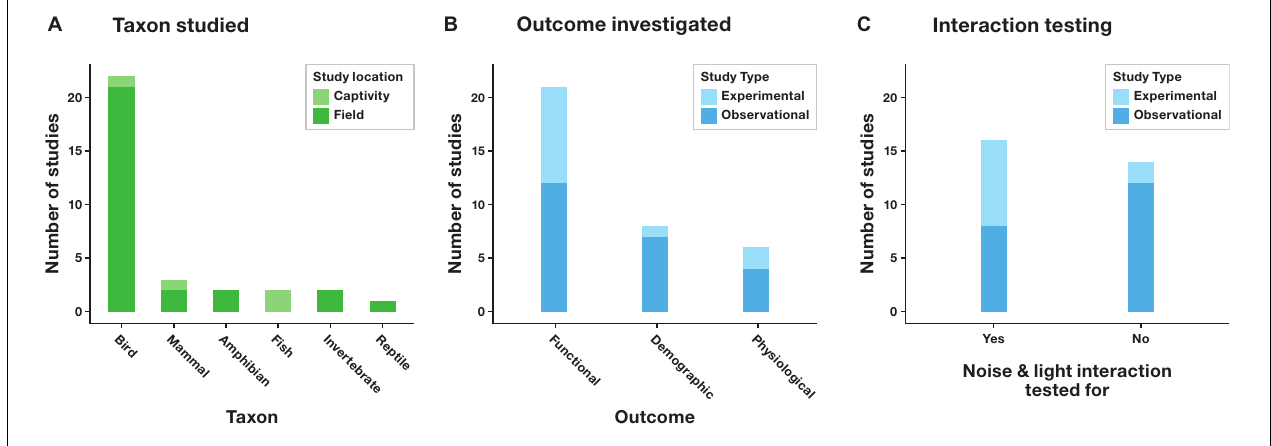
FIGURE 2 | (A) Taxa and (B) outcomes investigated in included studies, and (C) numbers of included studies where interaction effects were explicitly tested for.